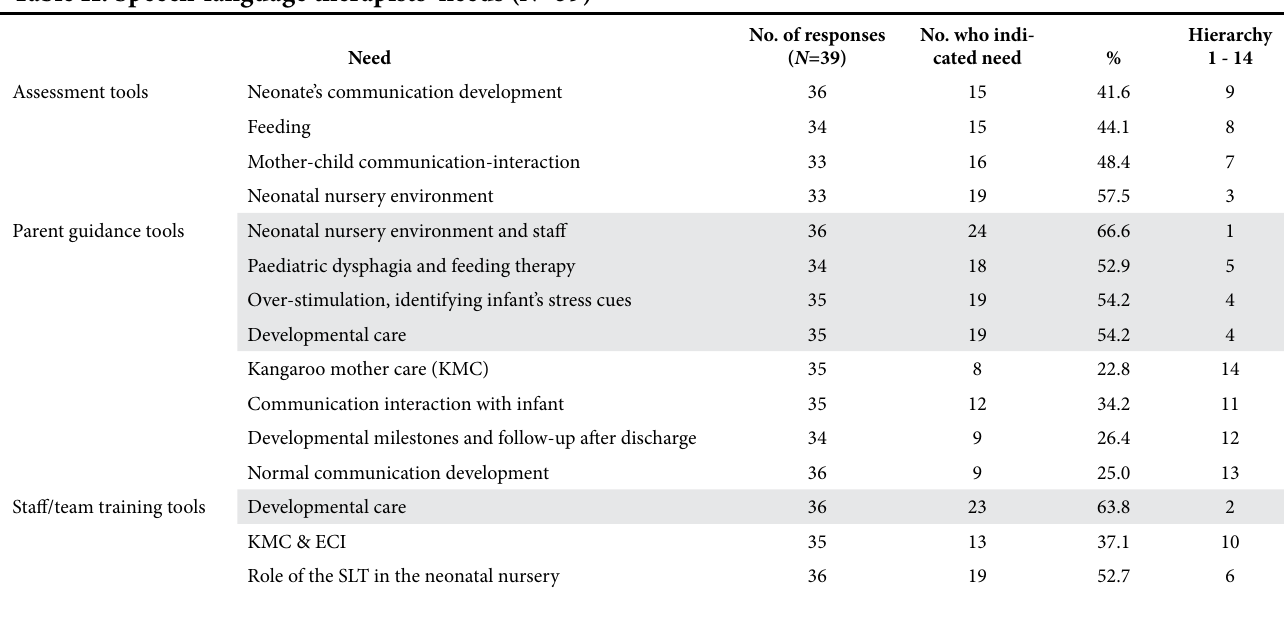
Table II. Speech-language therapists’ needs ( N =39)